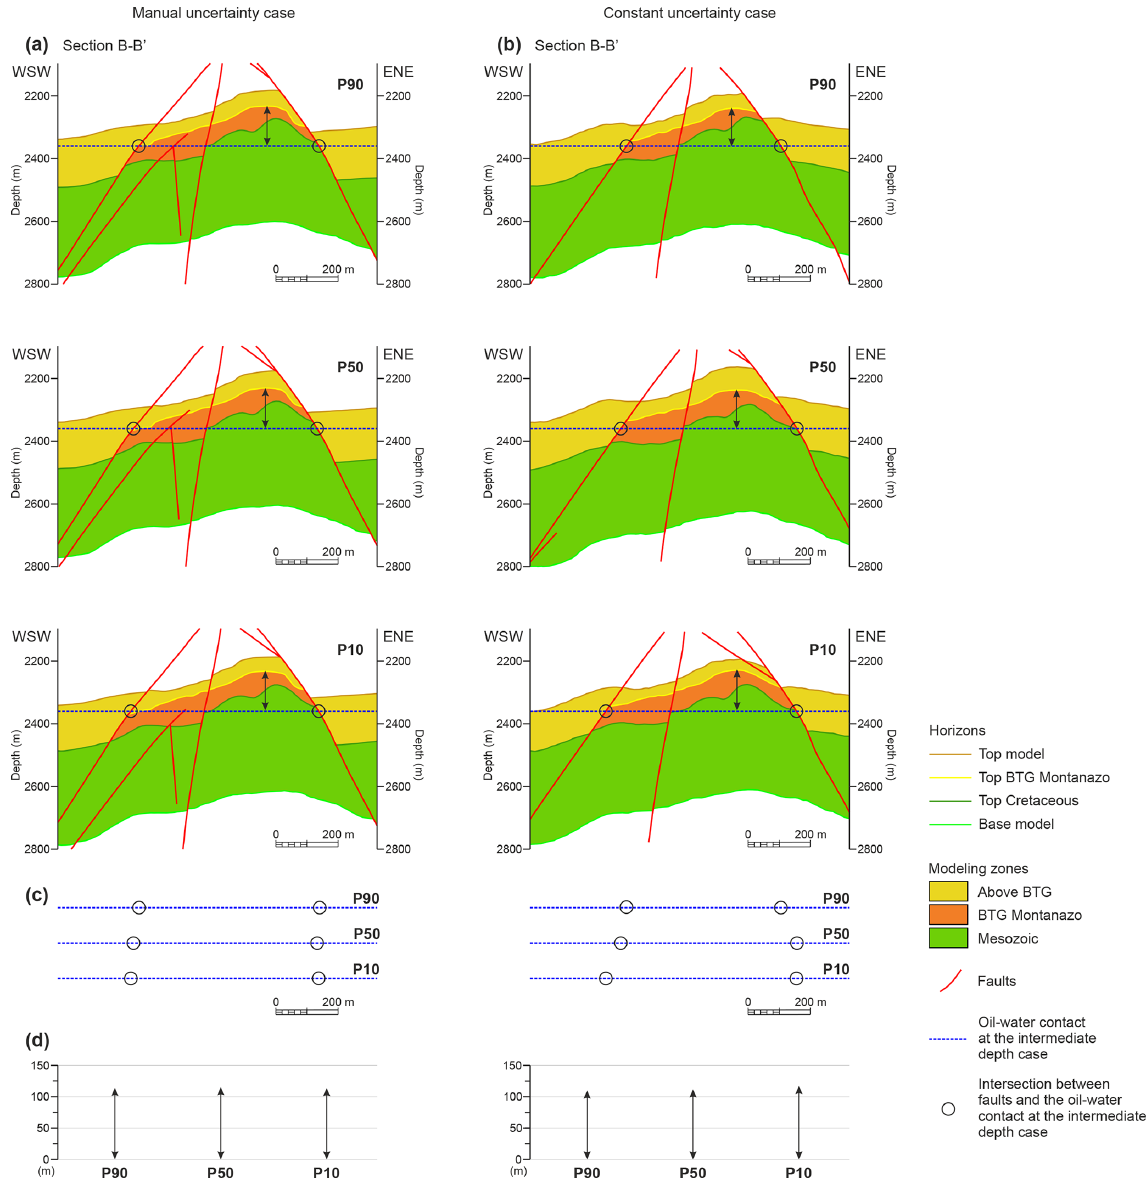
Figure 13. Cross section B–B’ of the structural model at the Montanazo culmination for the intermediate oil–water contact depth case showing the realizations corresponding to the proved (P90), probable (P50) and possible (P10) scenarios of the manual (a) and the constant (b) uncertainty cases. (c) Diagrams showing the position of the intersection between the major faults bounding the reservoir laterally and the oil–water contact for the P90, P50 and P10 scenarios. (d) Diagrams showing the maximum vertical distance between the reservoir top and the oil–water contact for the P90, P50 and P10 scenarios. Vertical exaggeration is 2 × . See the position of the section in Fig.